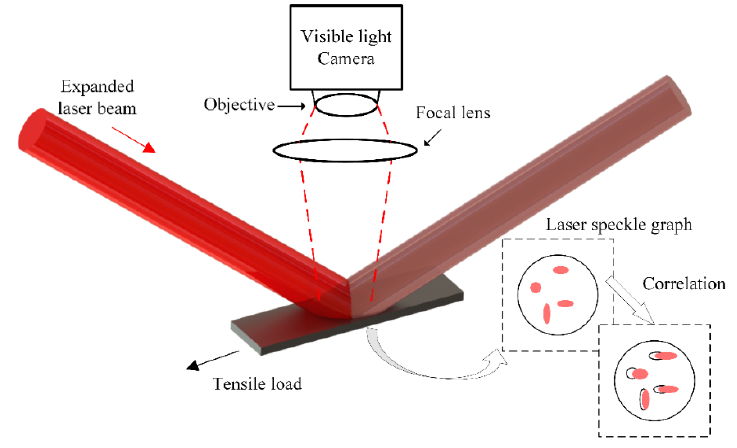
Figure 1. The schematic of digital-image correlation (DIC) strain evaluation.